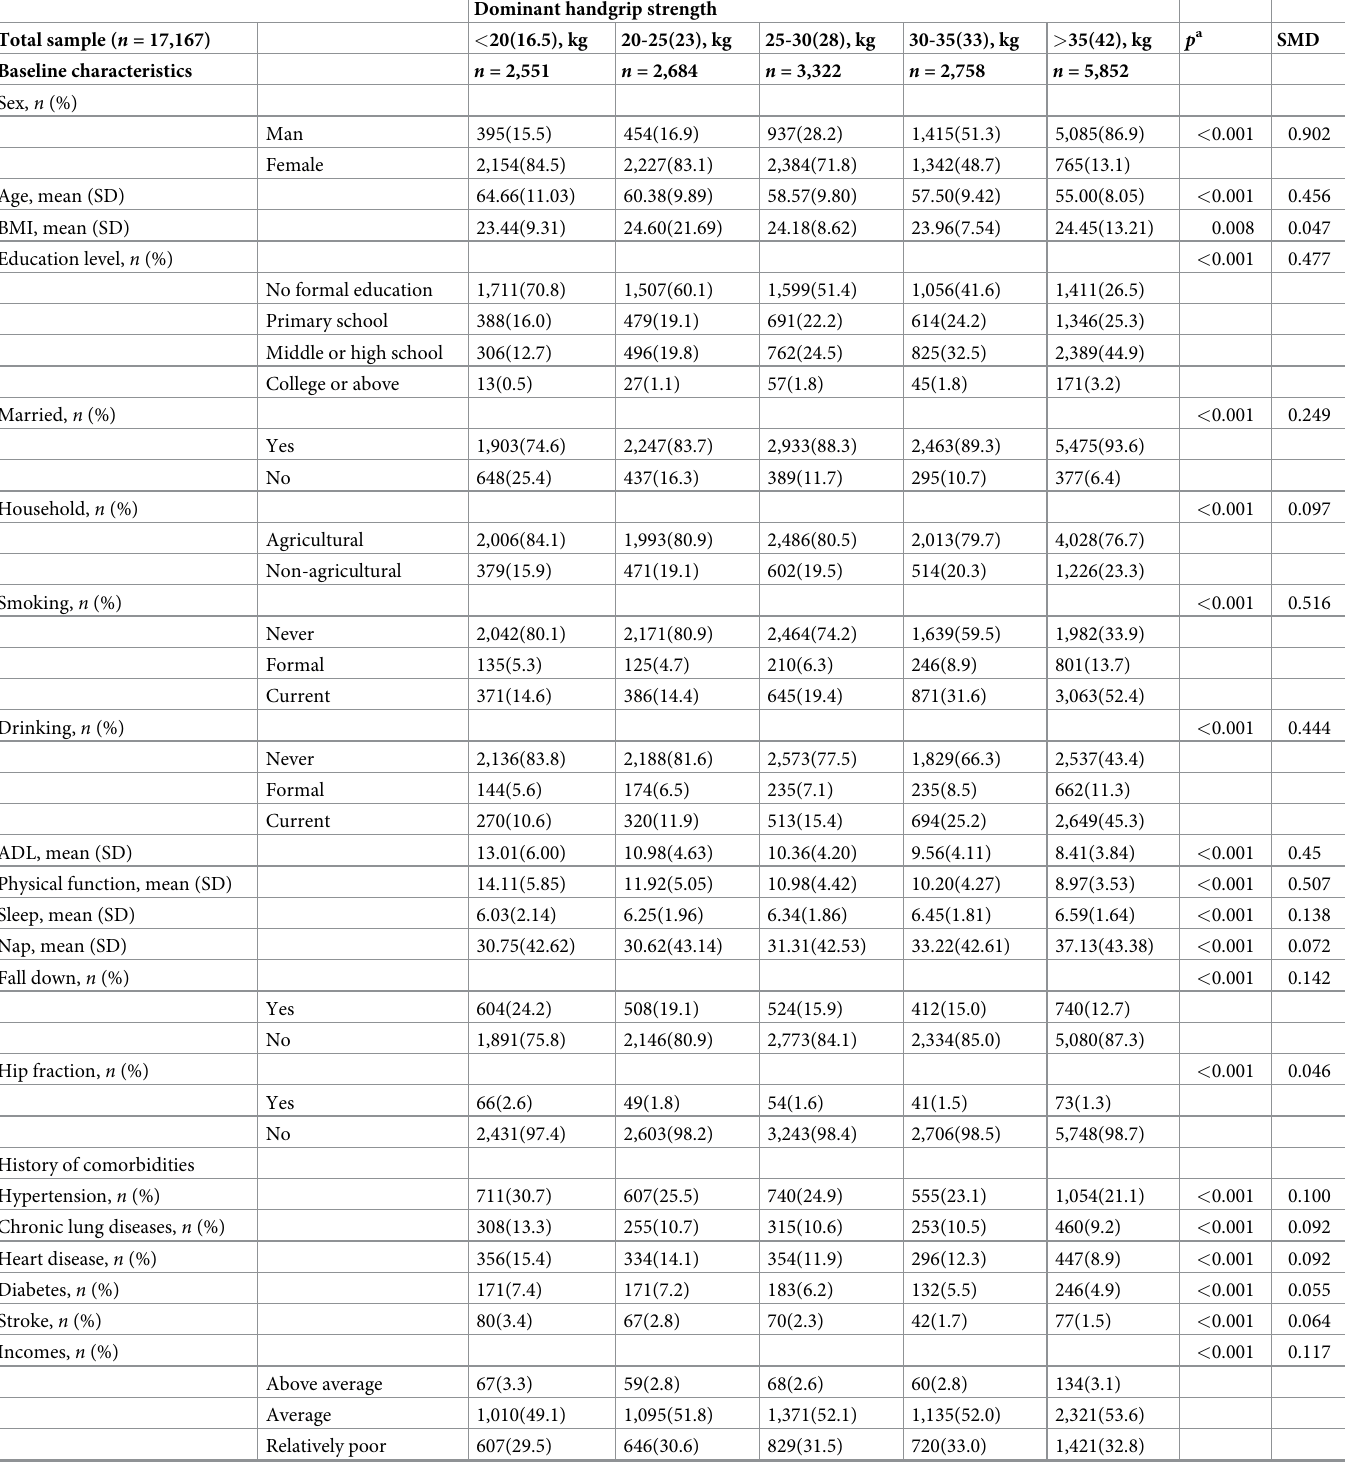
Table 1. Baseline characteristics of 17,167 participants according to